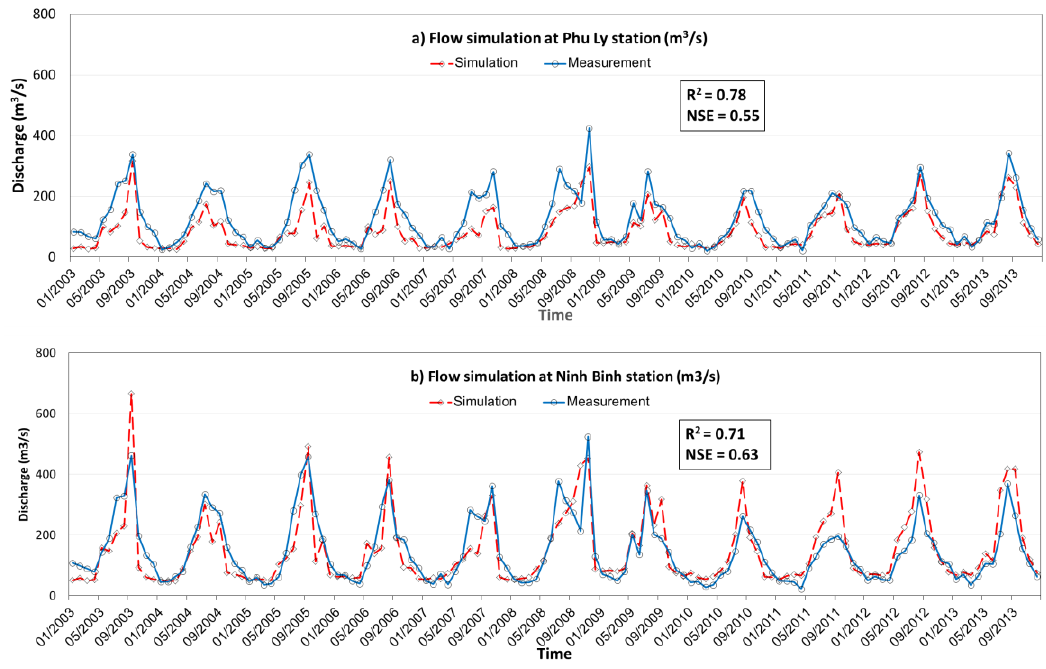
Figure 11. Flow simulation versus station measurements at Phu Ly ( a ) and Ninh Binh station ( b ).